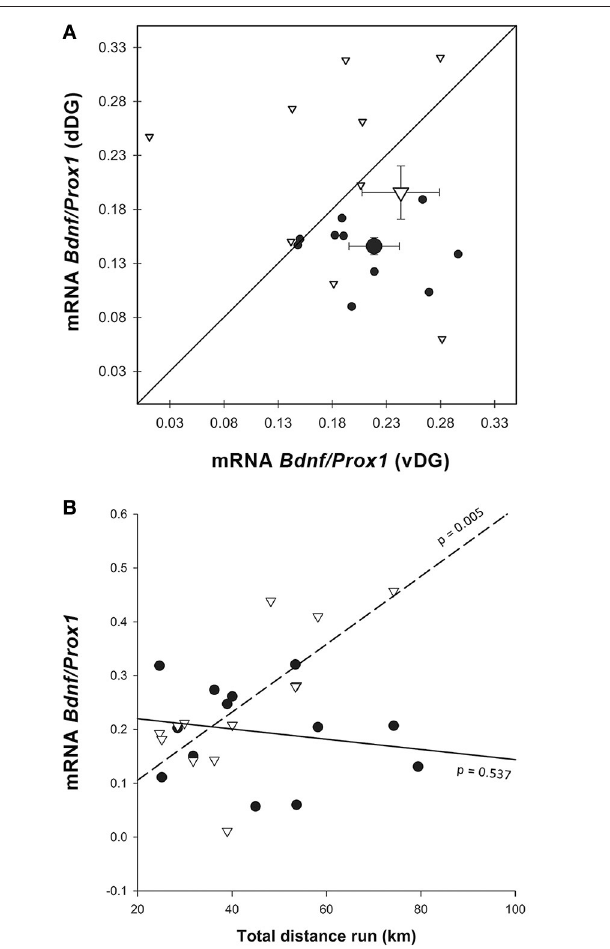
FIGURE 7 | Bdnf gene expression. (A) Most of the Enriched animals showed an increase in dorsal BDNF compared to controls, but some show a decrease, causing larger variability in that group and no significant difference from controls. Legend for (A) as in Figure 3G . (B) The effect of distance run, plotted against Bdnf mRNA showed a significant interaction, where Bdnf / Prox1 is correlated with running distance in vDG [ r 2 = 0.535, region*distance χ 2 (1) = 35.705, p < 0.001], but not dDG. Legend for (B) as in Figure 3H